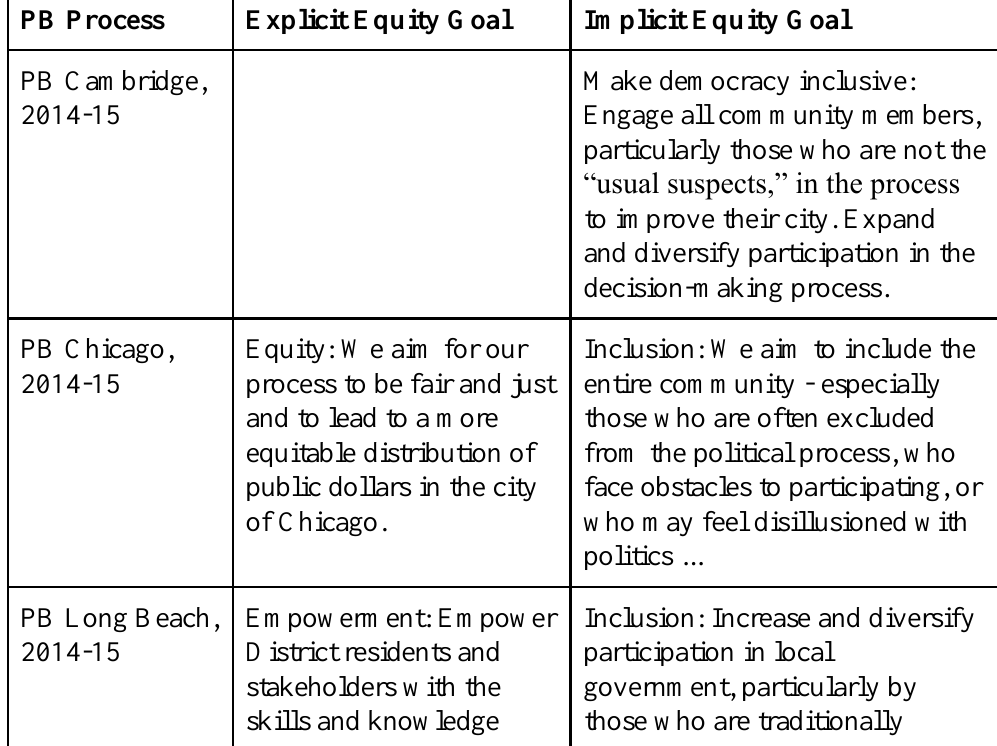
Table 1. Explicit and Implicit Equity Goals for PB Processes in the US PB